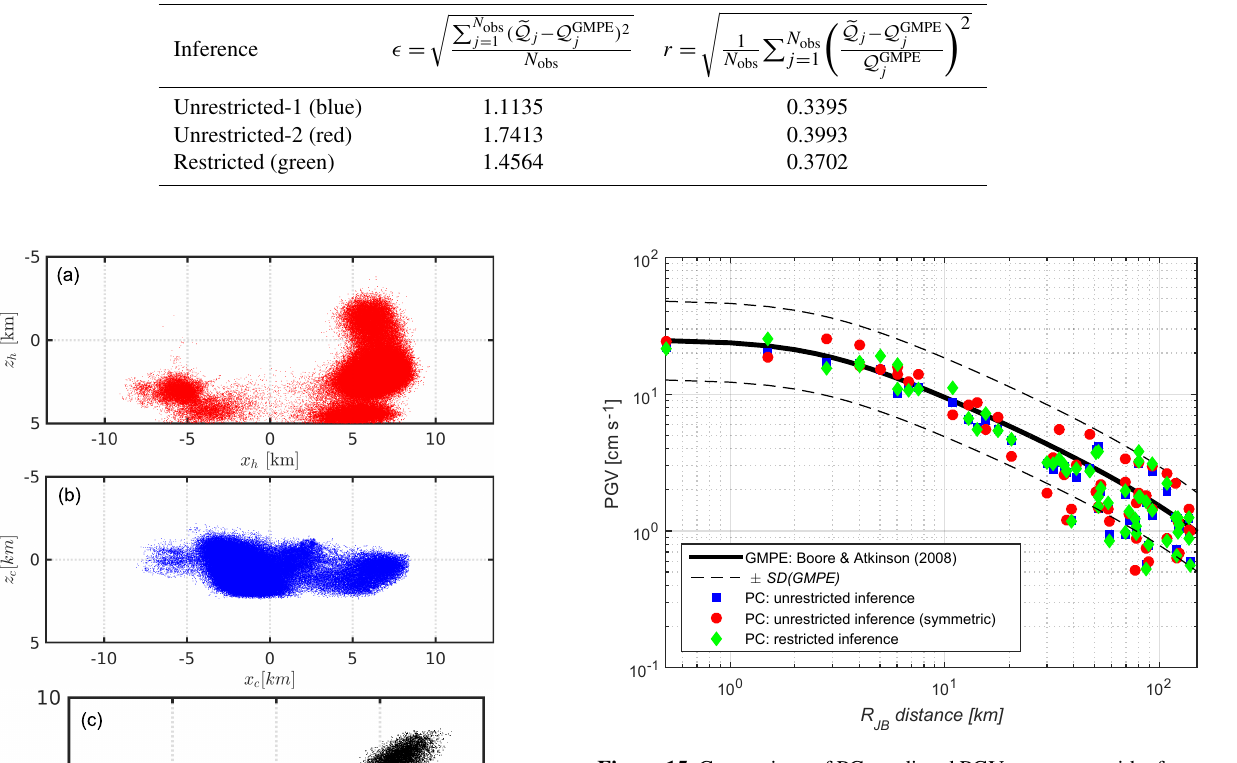
Figure 15. Comparison of PC-predicted PGV responses with afore- mentioned three inferred fault plane configurations with the refer- ence GMPE curve. Dashed lines are standard deviation bounds of GMPE